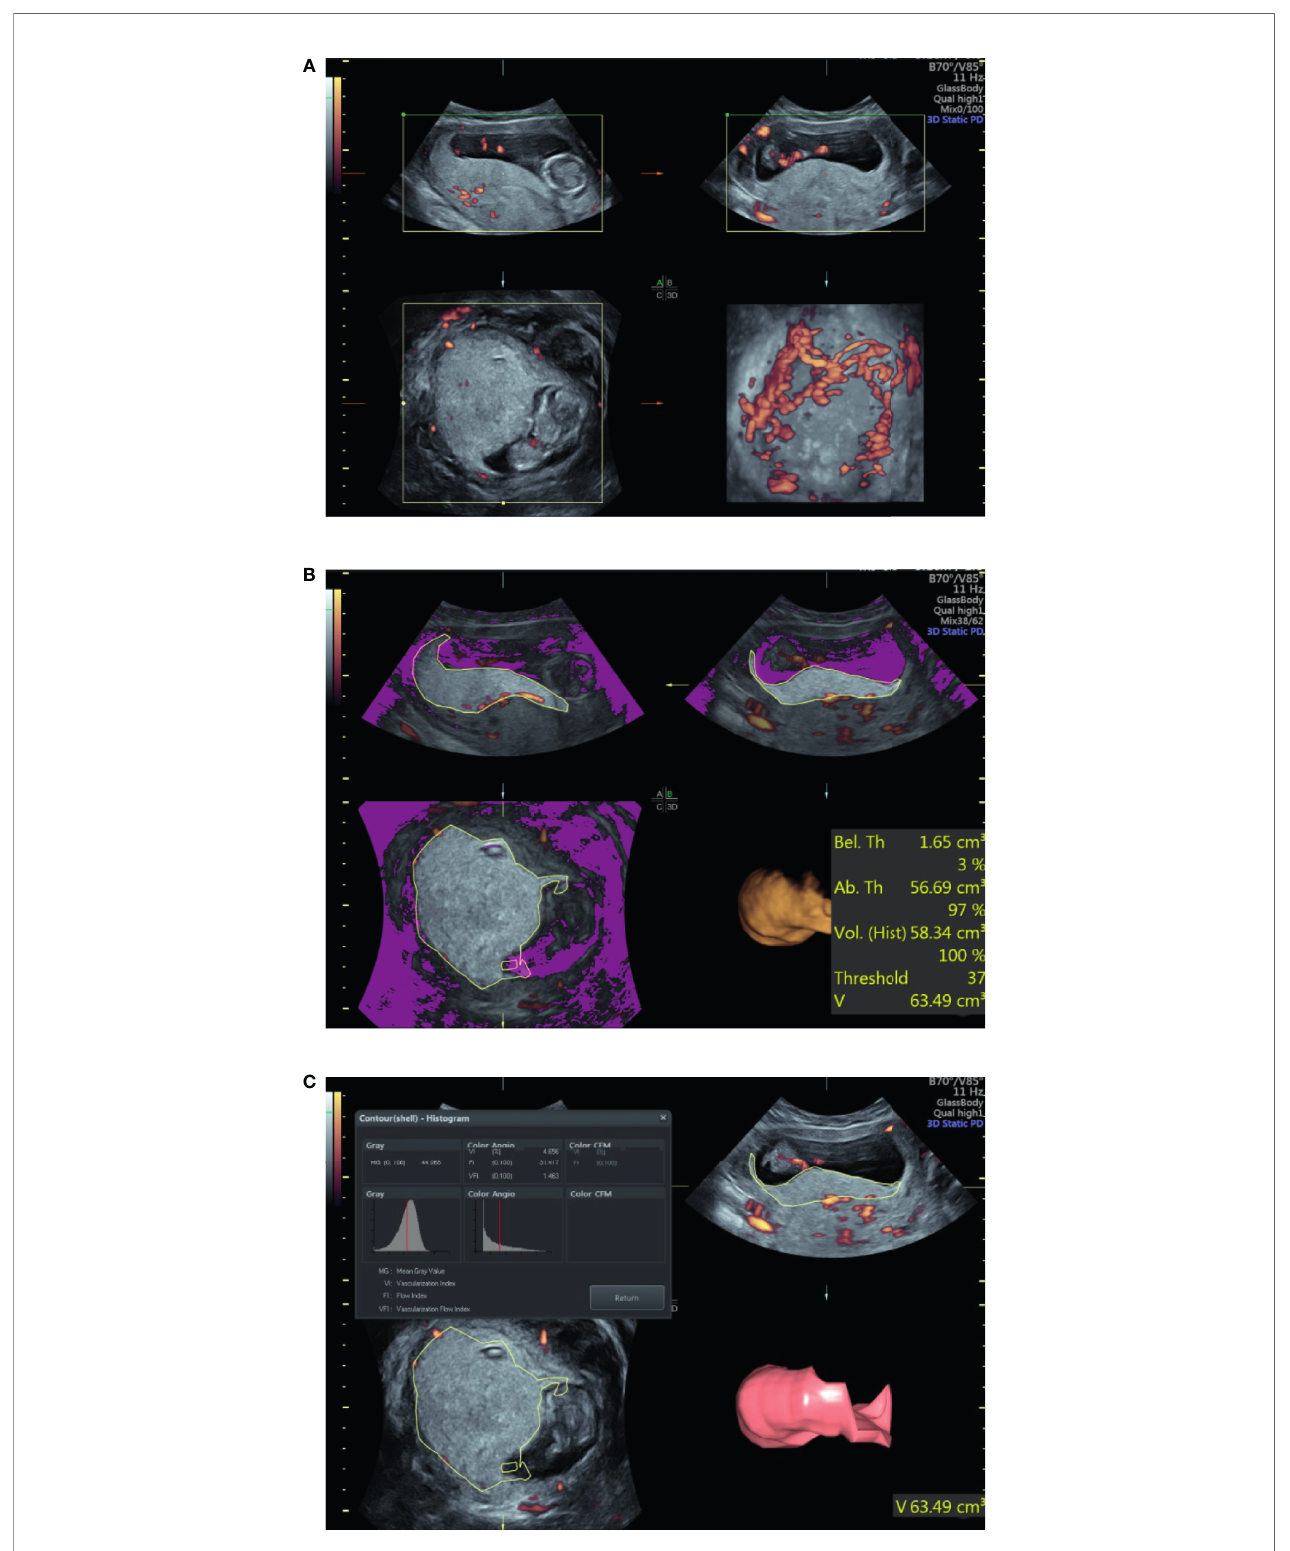
FIGURE 1 | Ultrasound examination of the placental volume and vascular perfusion. (A) Placental volume as determined by three-dimensional power Doppler. (B) Measurement of placental volume by VOCAL. (C) Placental vascular indices determined by three-dimensional power